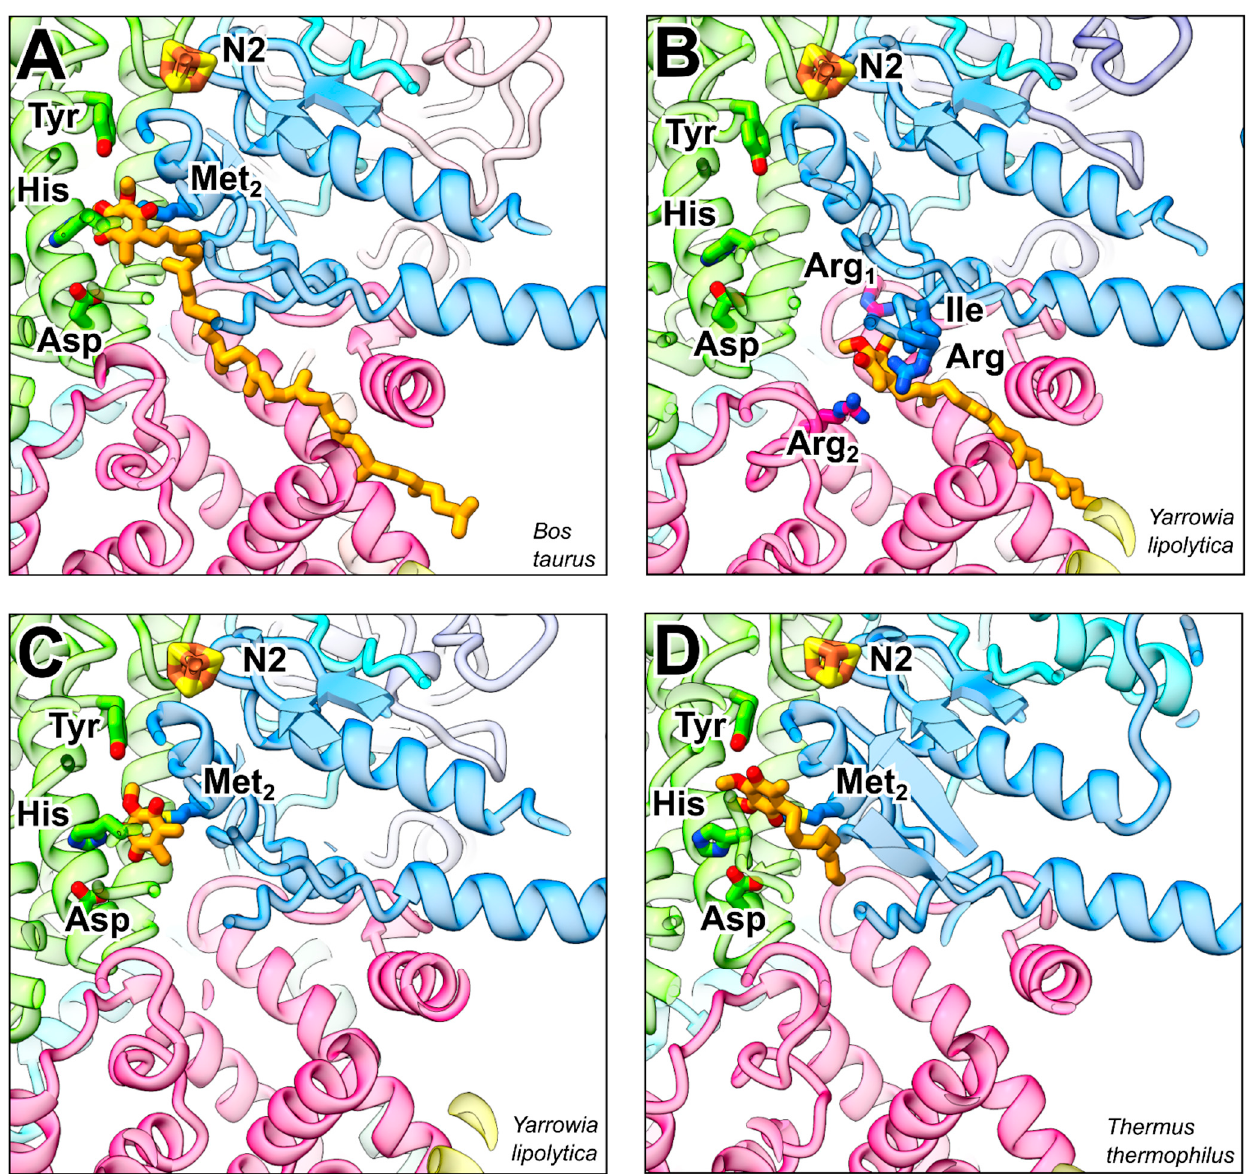
( E ) IACS-2858 (THF = tetrahydrofuran ring, THP = tetrahydropyran ring). ( F ) Architecture of res- piratory complex I with NDUFS7 (blue), NDUFS2(green), and ND1 (pink), and the Q tunnel . The viewpoint is indicated and the section of the detail view in Figures 2 and 3 is highlighted by a box. ( G ) Detail view of the Q reduction site and access pathway as shown in Figures 2 and 3; a tyrosine and a histidine residue of NDUFS2 play a key role for binding the Q head group (compare Figure 2, residue numbers see Table 1, for details see text).